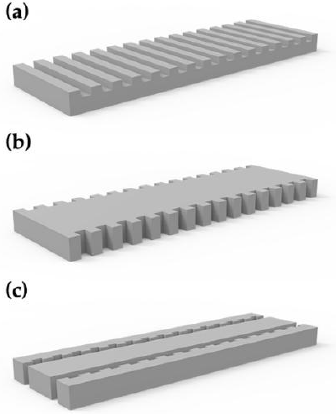
Figure 7. Structures of WBG: ( a ) surface WBG, ( b ) side wall WBG and ( c ) cladding WBG.